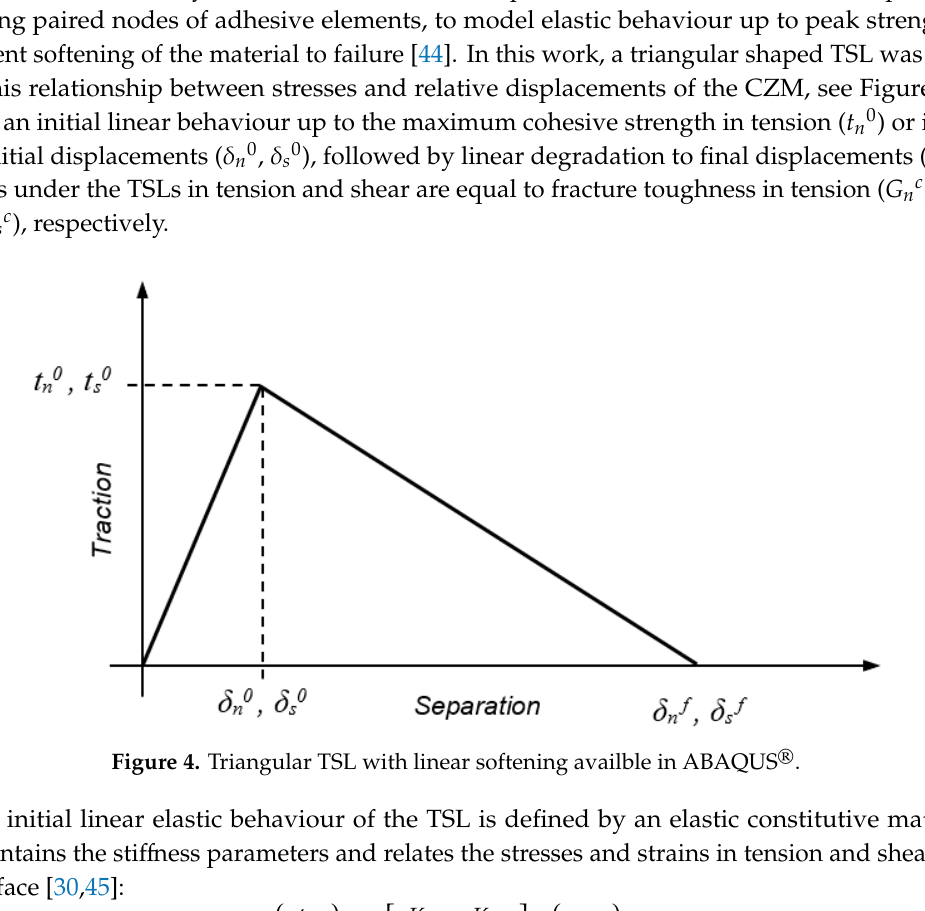
Figure 4. Triangular TSL with linear softening availble in ABAQUS ® .